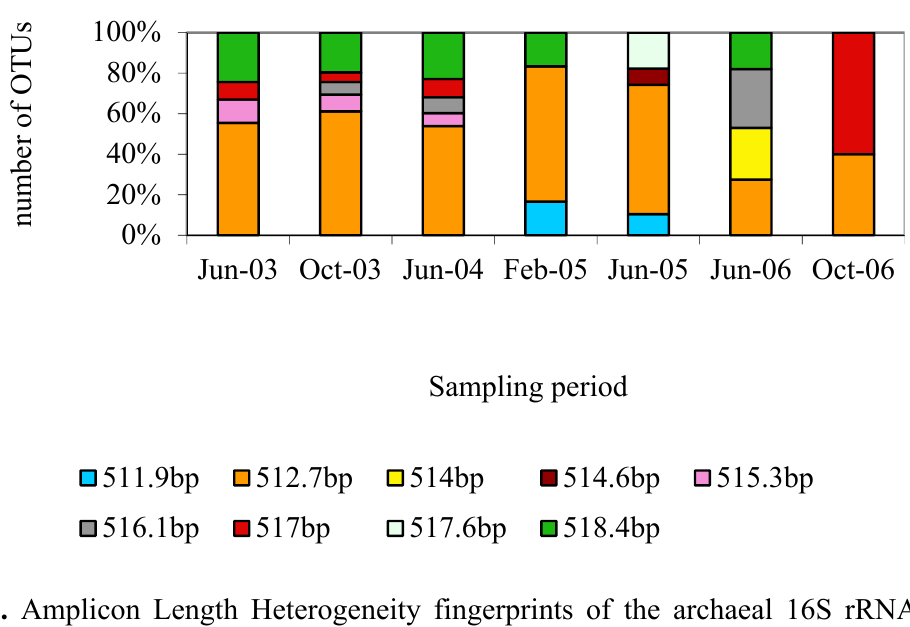
Figure 1. Amplicon Length Heterogeneity fingerprints of the archaeal 16S rRNA gene fragments. The Y-axis shows the percentage representation (relative abundance) of each OTU (operational taxonomic unit) had in the population. Each OTU length is given in base pairs and is indicated by a separate color (see